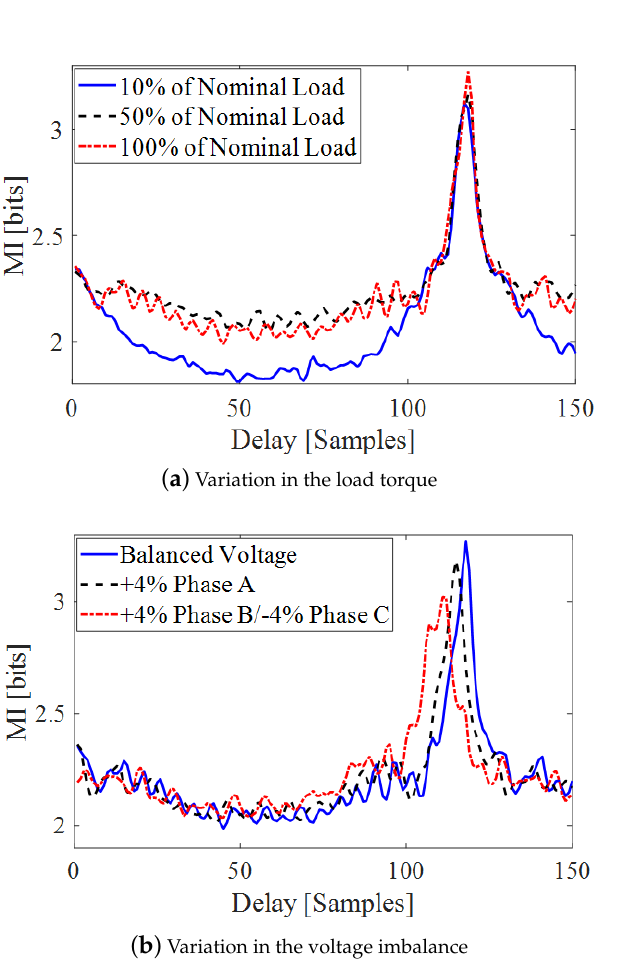
Figure 5. Analyzes of variations in the load torque and voltage imbalance levels—Motor 1 operating without